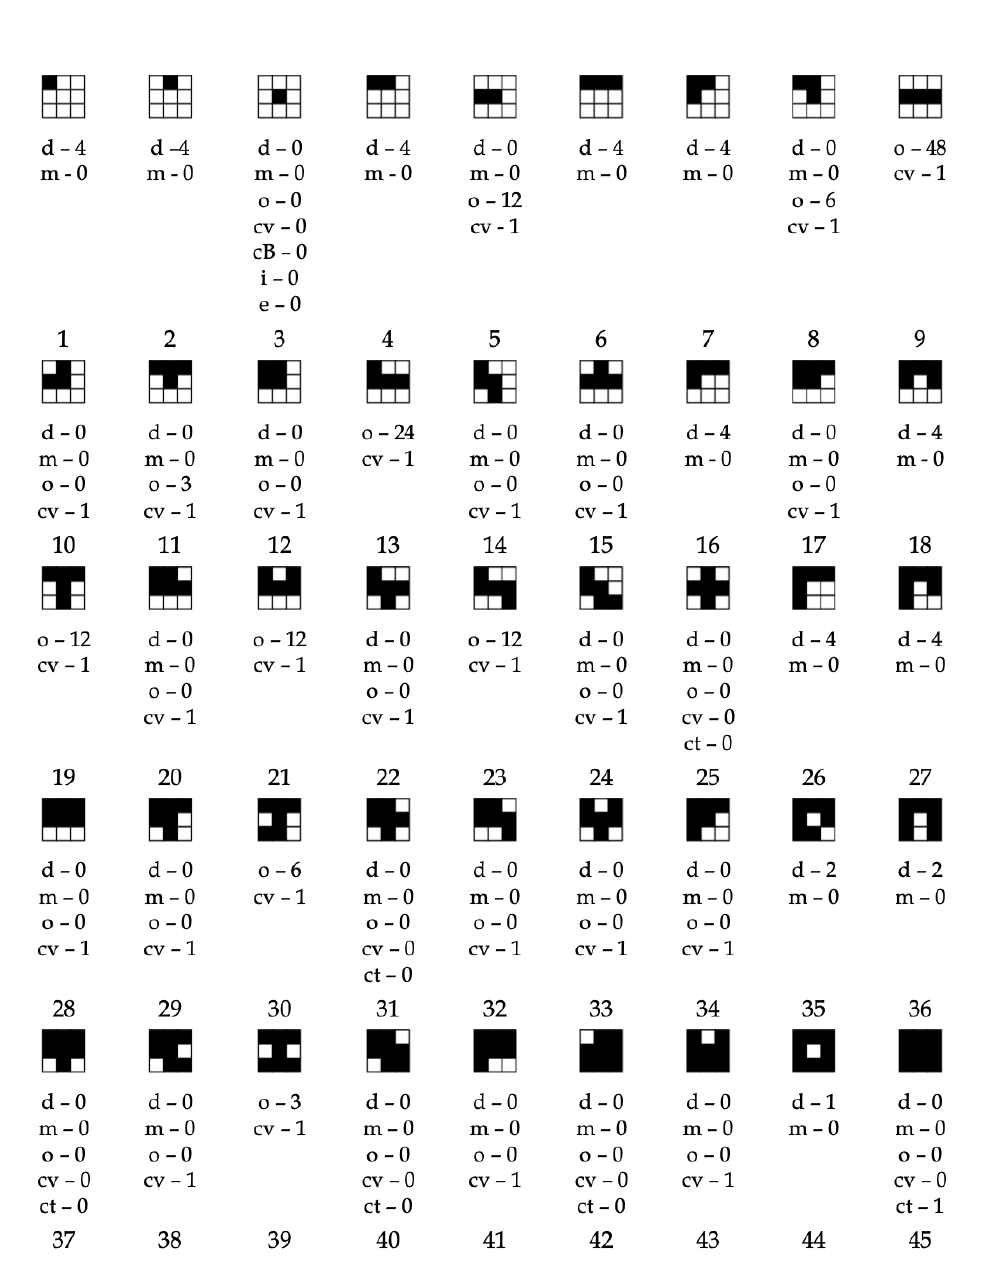
Figure 14: Topological augmentations from the congruence class that always produce the named topological relation. The numbers presented reflect only one symbol from the con- gruence